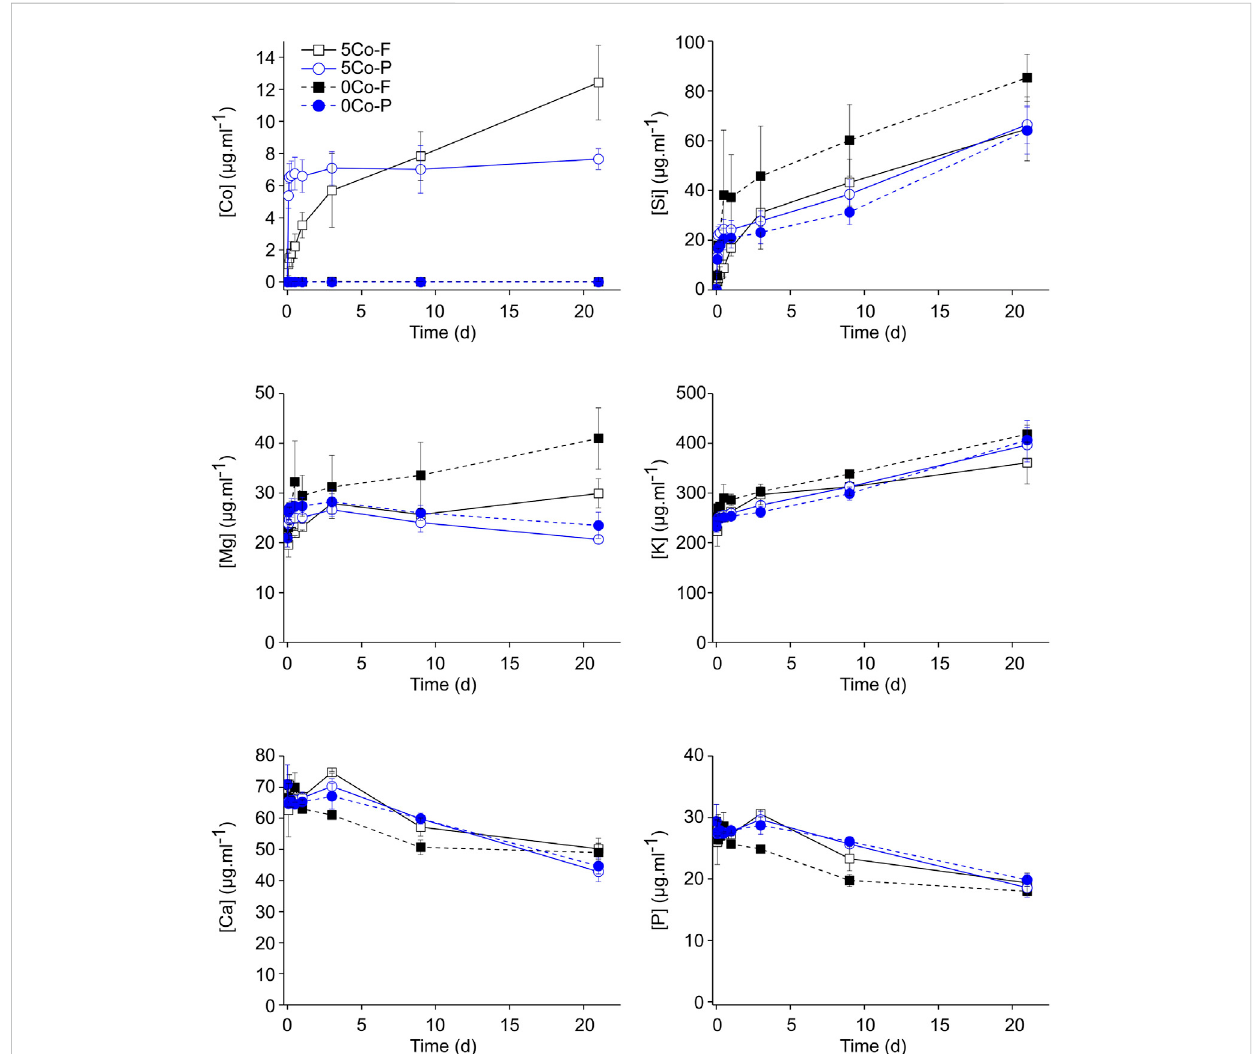
FIGURE 2 Elemental concentration in DMEM after incubation with 5Co and 0Co glass fi bres (5Co-F and 0Co-F) and particles (5Co-P and 0Co-P) at a concentration of 1.5 mg ml − 1 as a function of time of immersion. Data is represented as the mean ± standard deviation with N = 3.